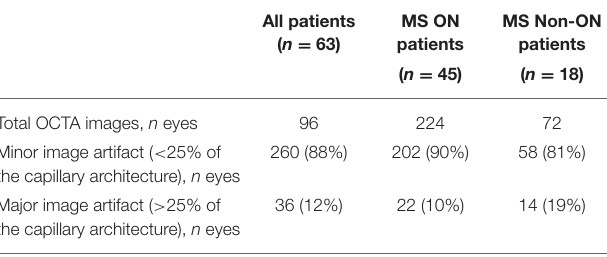
TABLE 2 | Demographic and clinical characteristics of participants.